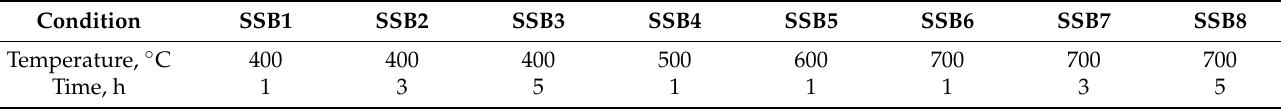
Figure 2. Diagram of pyrolysis reactor set. Table 1. Conditions of the pyrolysis process and product abbreviations used.